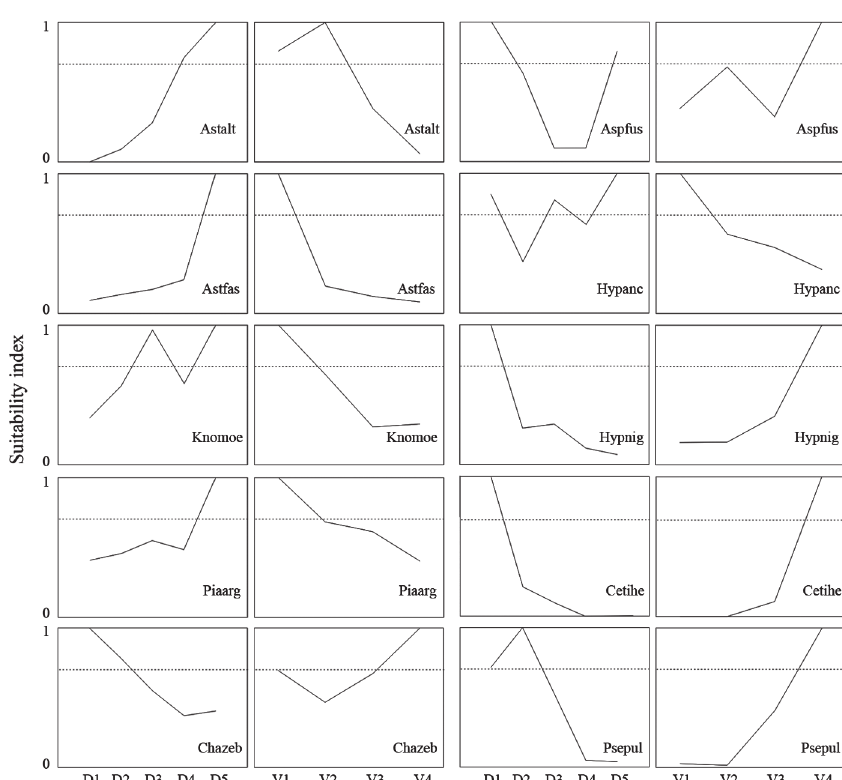
Fig. 2. Habitat suitability criteria for depth and velocity of 10 species (codes in Table 1) developed for forested streams, considering five classes of depth (D1 = 0 to 0.2 m; D2 = 0.21 to 0.30 m; D3 = 0.31 to 0.40 m; D4 = 0.41 to 0.50 m; D5 > 0.51 m) and four classes of velocity (V1 = > 0.0 to 0.2 m/s; V2 = 0.21 to 0.40 m/s; V3 = 0.41 to 0.60 m/s; V4 > 0.61 m/s). The dotted lines indicate SI = 0.7, above which conditions were considered